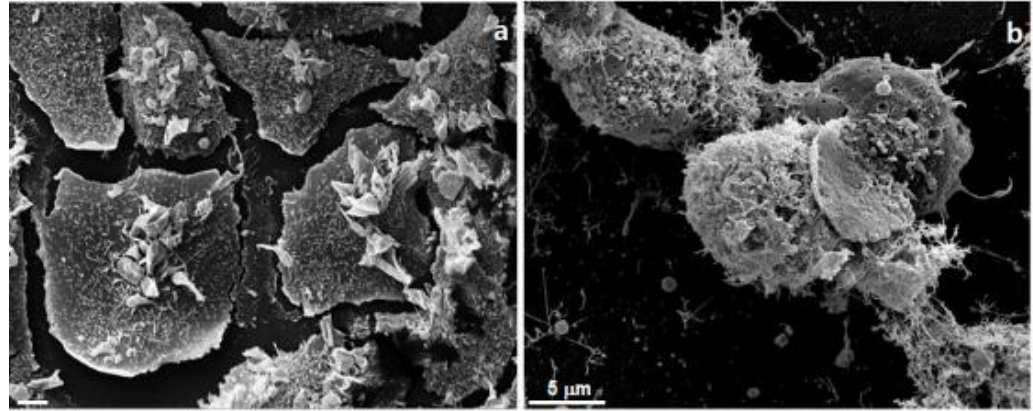
Figure 2. Scanning electron microscopy image of SKBR3 cells ( a ) (5 µ m) and incubated with Mentha suaveolens EO for 24 h ( b ).